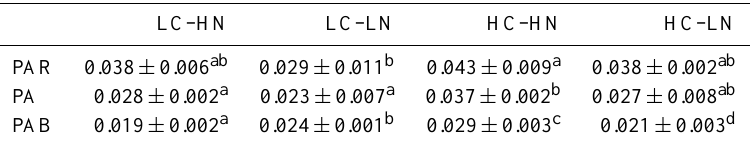
treatments at P< 0 . 05. 3